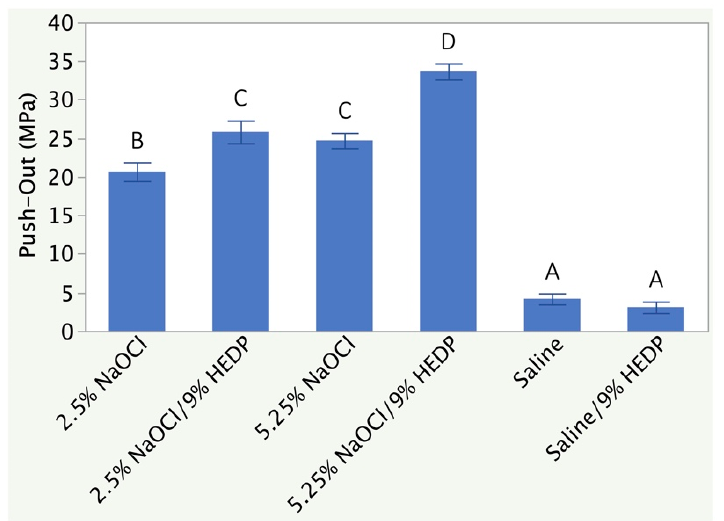
Figure 3. Dislodgment resistance of the hydraulic CaSi sealer under investigation (BioRoot RCS). Identical superscript letters indicate that there was no difference between data sets at the 5% level (one-way ANOVA, Tukey’s HSD).